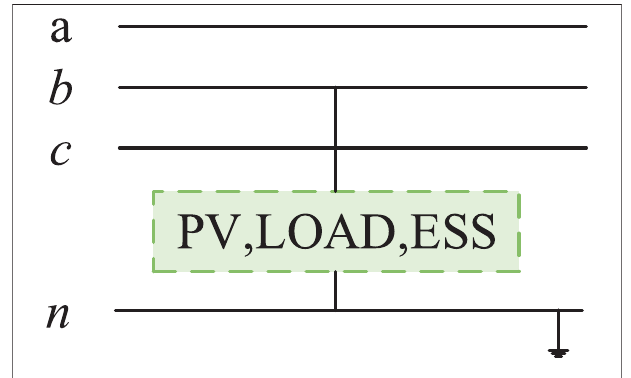
FIGURE 2 | Illustration of PV, LOAD and ESS connection at phase